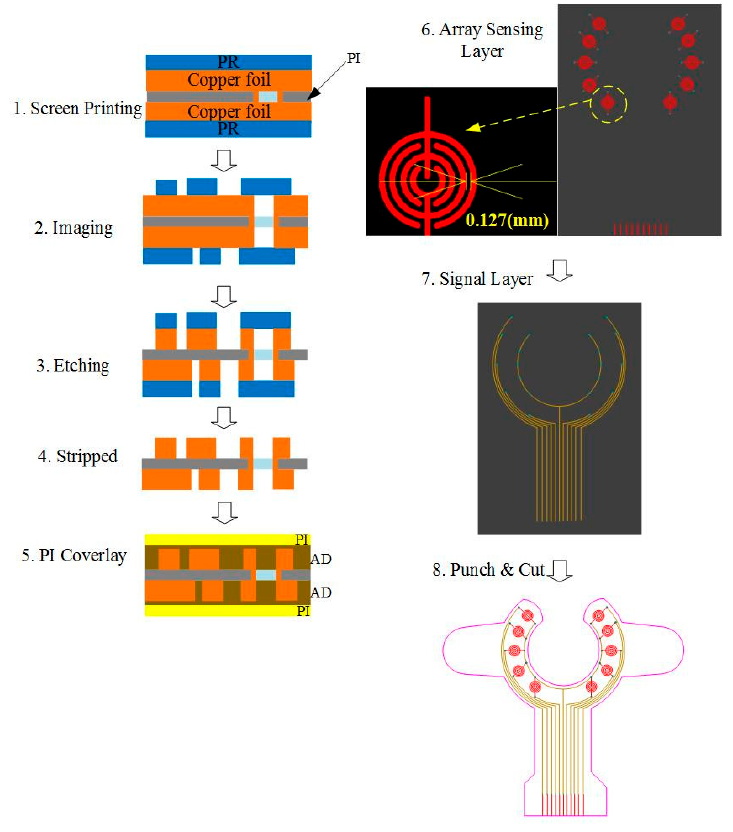
Figure 2. Flowchart for array sensor production.